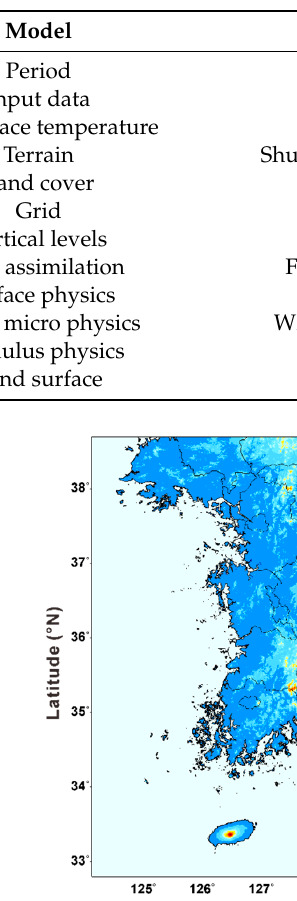
Table 1. Model configuration of Weather Research and Forecasting (WRF).